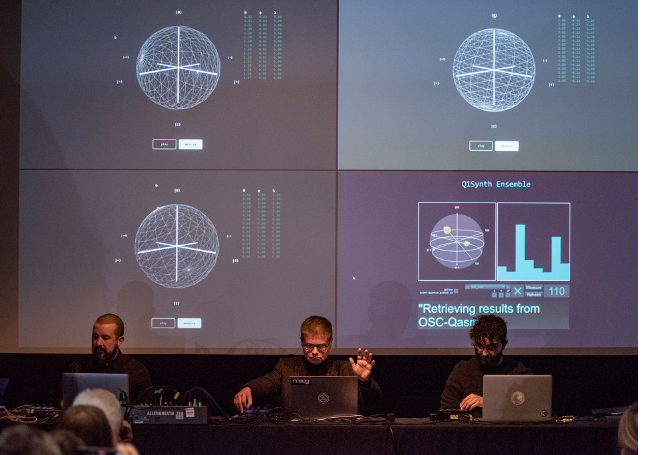
Figure 8. Premiere of Spinnings at the Goethe-Institut, starring P.T. (on the left ), E.R.M (in the middle ), and P.V.I. (on the right